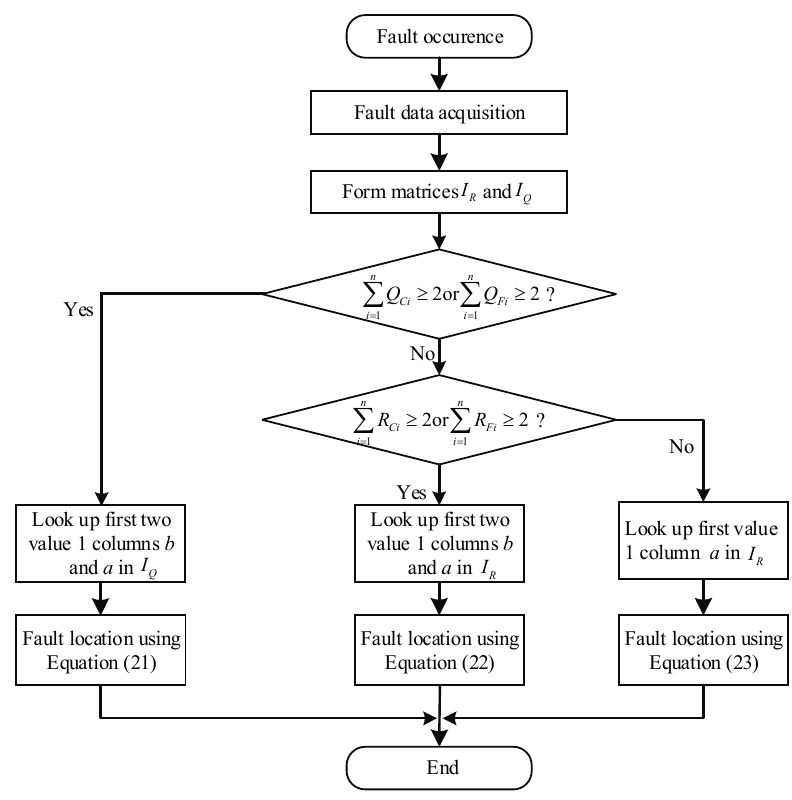
Figure 9. Flowchart of the proposed fault location scheme.